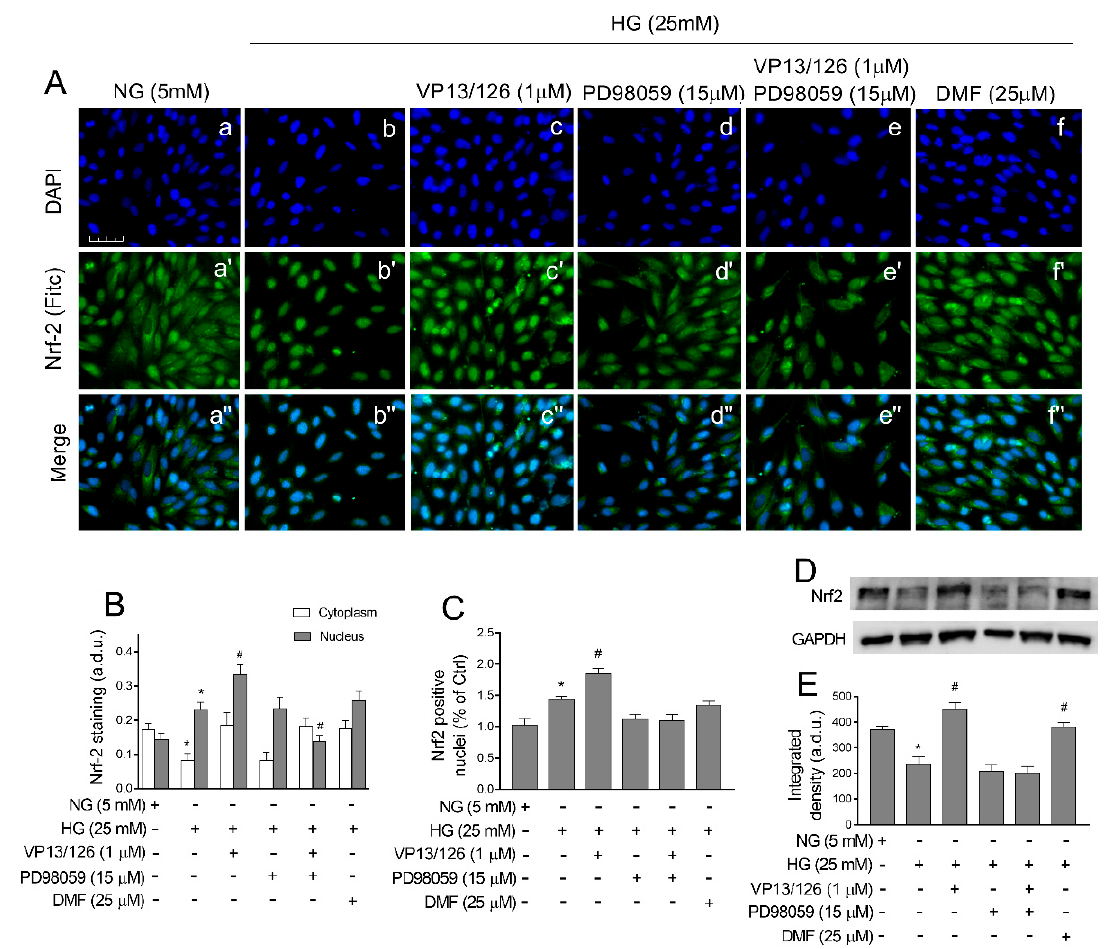
Figure 6. Nrf2 nuclear translocation and protein levels up-regulation in SIRC stimulated in high glucose in presence of VP13/126 or DMF. ( A ) shows representatives images of immunocytochemical stained for Nrf2 in SIRC cultured in normal glucose or in HG, (25 mM) without or with 1 µ M VP13/126, 15 µ M PD98059, VP13/126 plus PD98059 and 25 µ M of DMF for 48 h (in green: a’–f’, respectively). Moreover, relative NucBlue-stained nuclei (a–f, respectively) and merged channels (a”–f”, respectively) are shown. All images were acquired with the Operetta High-Content Imaging System using a 20 × magnification; scale bar = 100 µ m. ( B ): high-content screening analysis was used to quantify green fluorescence (Fitc) relative to Nrf2 staining in cytoplasm and nuclei. ( C ): quantification of Nrf2 positive nuclei in SIRC stimulated with high glucose in presence of VP13/126 or DMF. ( D ): Western blot analysis of Nrf2 protein levels in whole lysates of SIRC treated with high glucose in presence of VP13/126 or DMF. GAPDH detection indicates the same loading of 40 µ g of proteins in each lane. ( E ): immunoblot quantification through densitometric analysis of each band (in arbitrary density units, a. d. u.) performed by Image J software. Data are expressed as media ± SEM from at least six fields/well randomly selected and each reporting more than 15 cells/field. All data represent mean ± SEM obtained from at least three independent experiments. * p < 0.05 vs. control (Crtl); # p < 0.05 vs. HG. One-way ANOVA, followed by Tukey’s test.